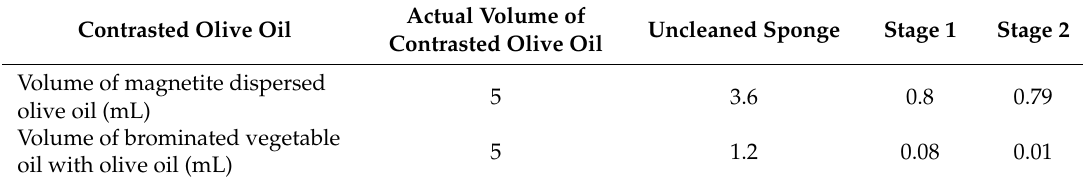
Table 2. Volume of contrasted olive oil at different stages of cleaning indicating the removal of contrasted olive oil from the sponge. Stage 1 of cleaning process: soiled sponge thoroughly rinsed with 5 mL of detergent is squeezed for 10 min at 10 cycles/min with continuous water feed.